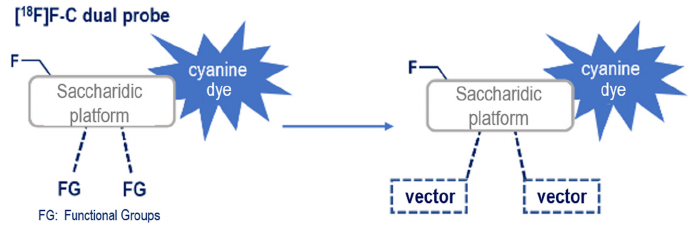
Figure 1. [ 18 F]F-C cyanine-containing dual probe and late-stage vector grafting.